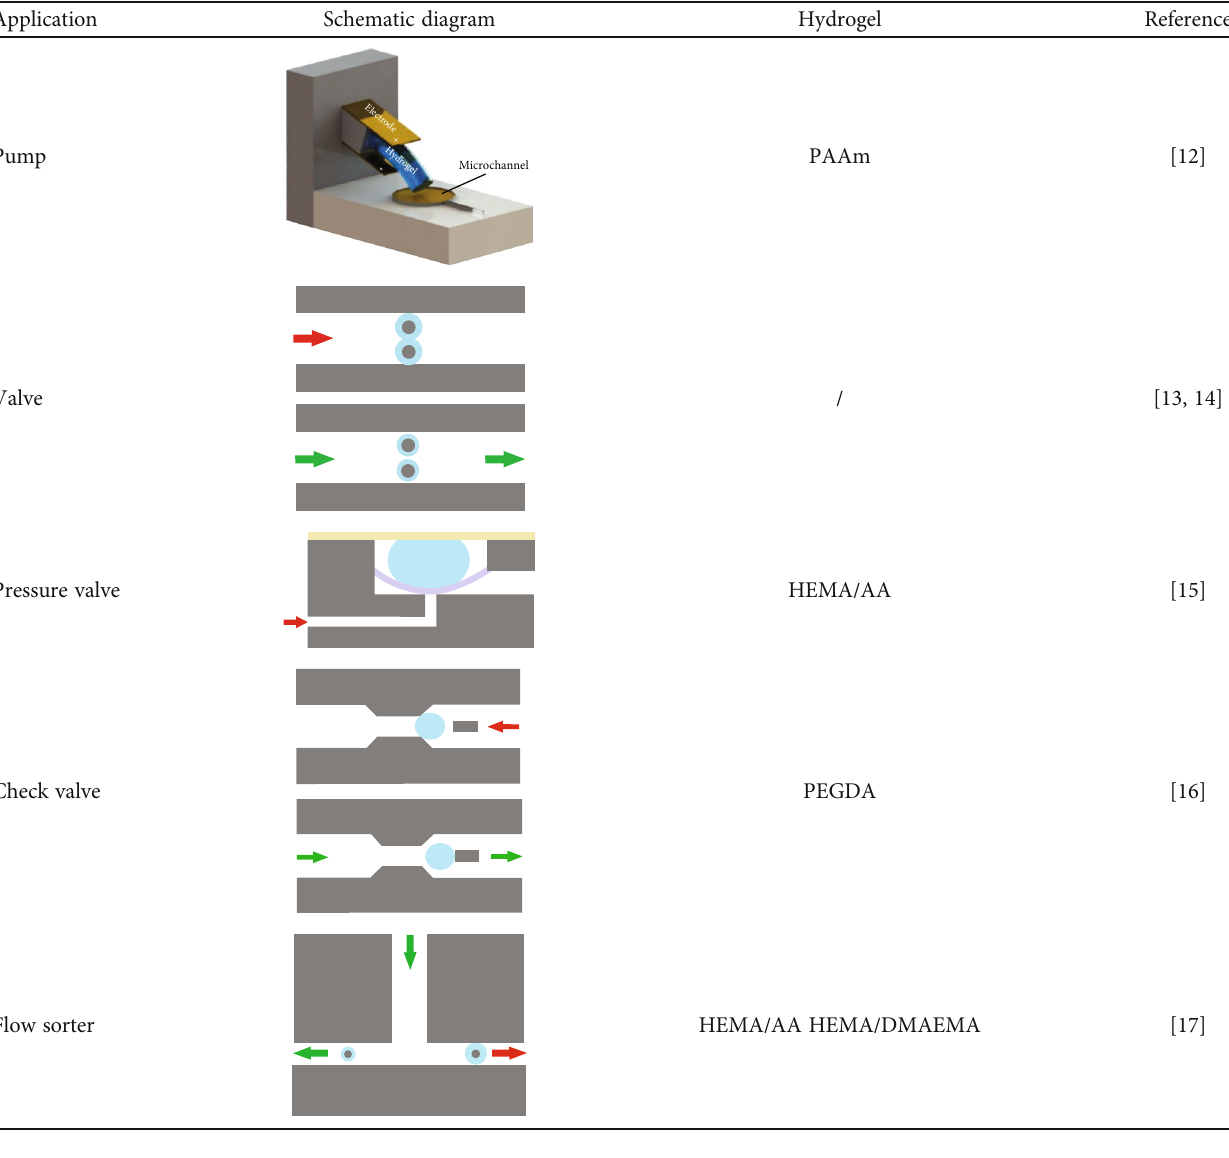
Table 1: Overview of several applications of the hydrogel in fl uidic devices.